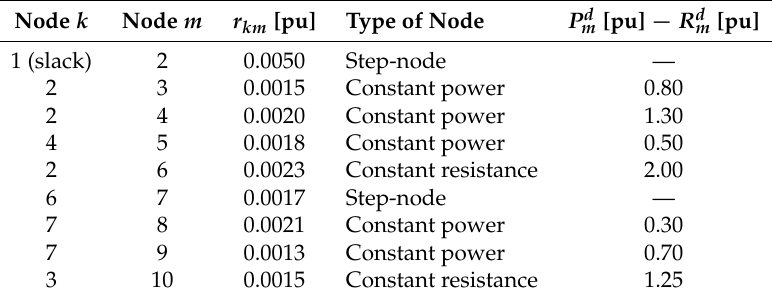
Table 1. Electrical parameters of the 10-nodes test feeder.